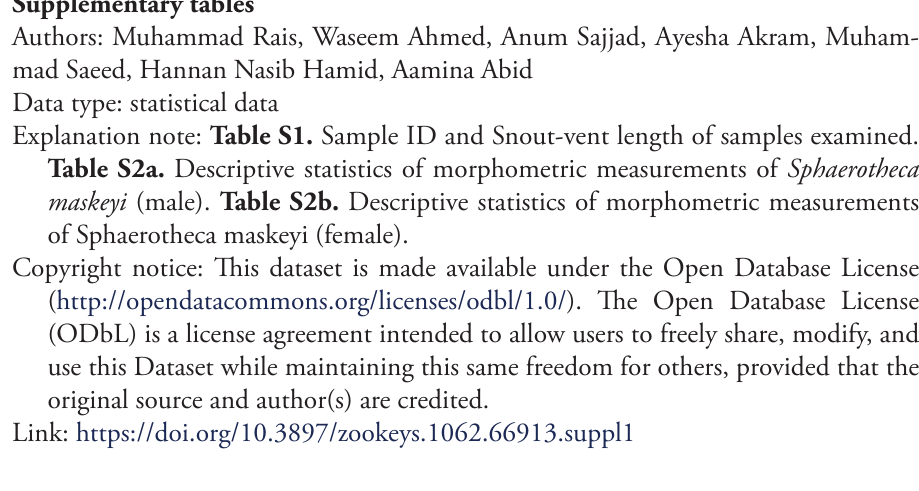
Explanation note: Table S1. Sample ID and Snout-vent length of samples examined. Table S2a. Descriptive statistics of morphometric measurements of Sphaerotheca maskeyi (male). Table S2b. Descriptive statistics of morphometric measurements of Sphaerotheca maskeyi